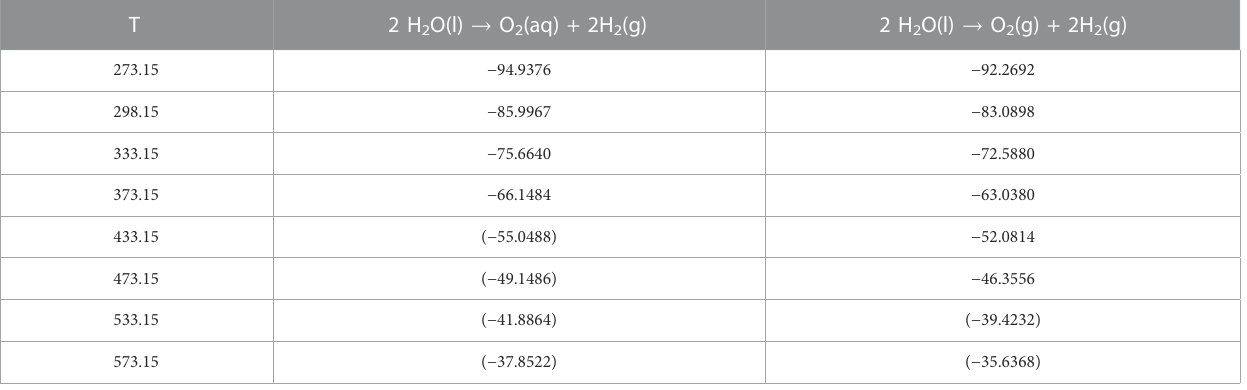
TABLE 7 Calculated equilibrium constants for E H reactions (Eqs 4, 5) as a function of temperature. Values in brackets are beyond the recommended range of validity.